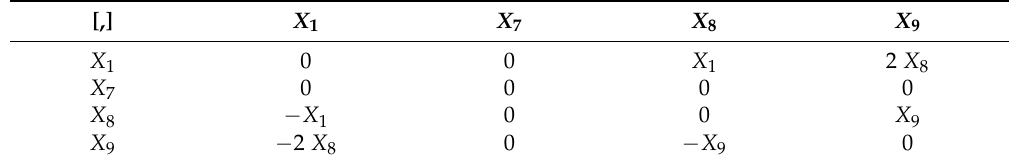
Table 8. Lie brackets for Cases 9 and